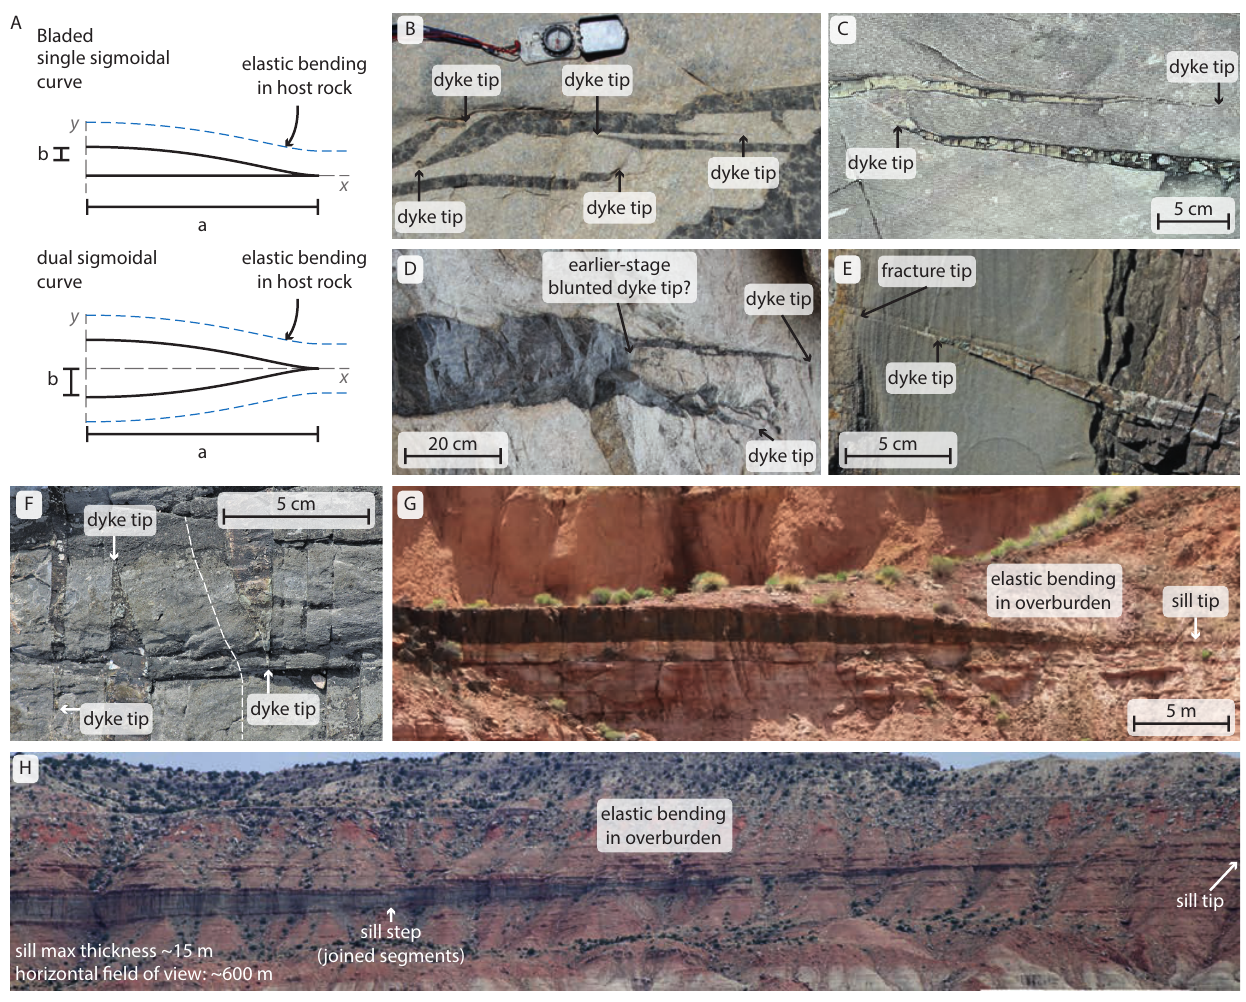
Figure 1: Examples of bladed sheet intrusion tip geometries. [A] Idealised tip form for bladed intrusions. [B]